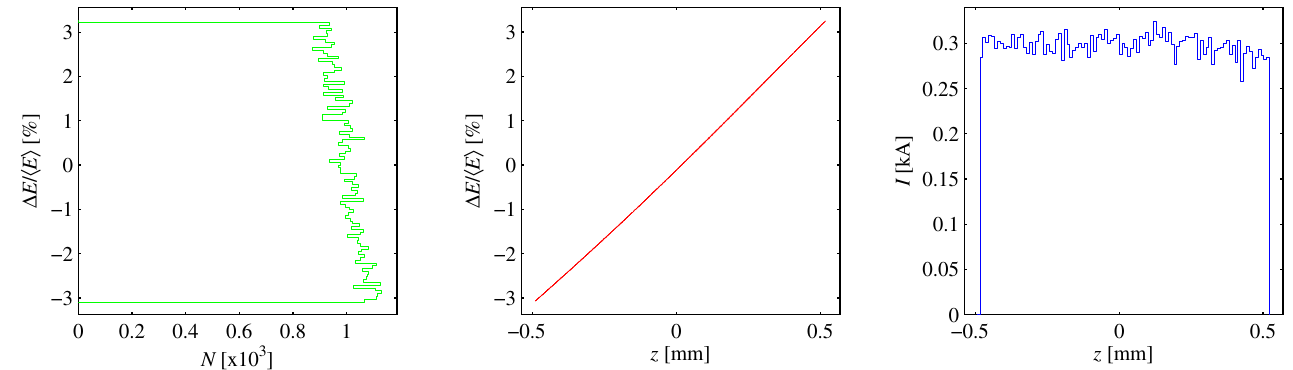
FIG. 5. (Color) Energy profile (left), longitudinal phase space (middle), and bunch current distribution (right) after the chicane when a fourth-harmonic rf system (x band) is used.